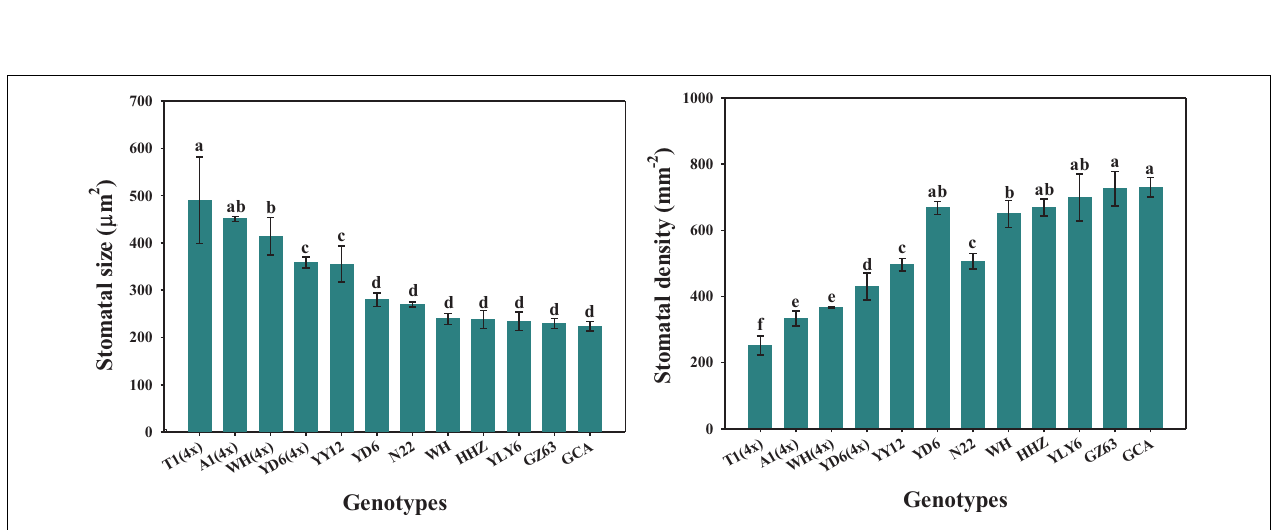
Frontiers in Plant Science |